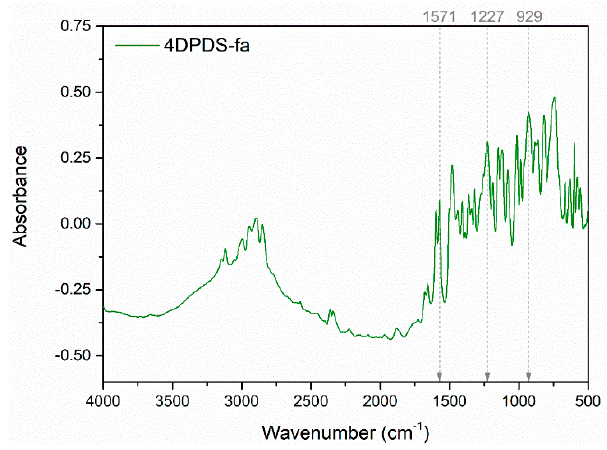
Figure A4. 13 C NMR spectrum in CDCl 3 of 3DPDS-fa.